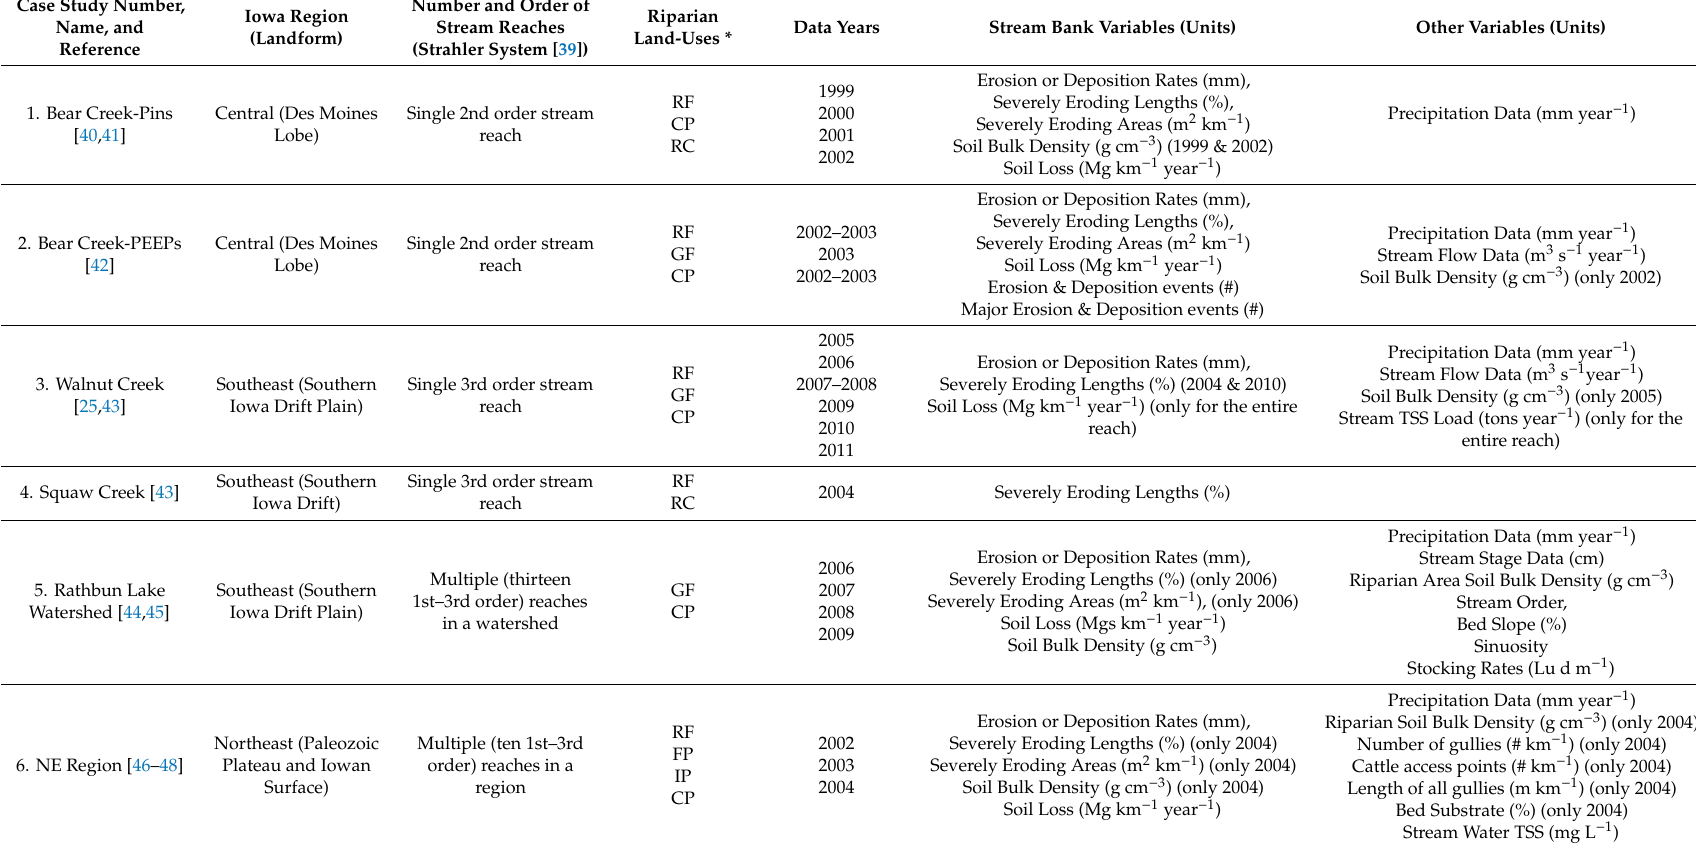
Table 1. Case study characteristics, study periods, and variables measured or